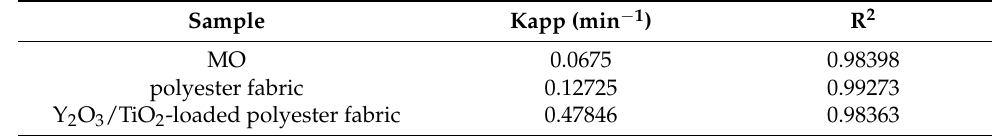
Table 1. Pseudo-first-order rate constants of photocatalytic degradation of methyl orange.